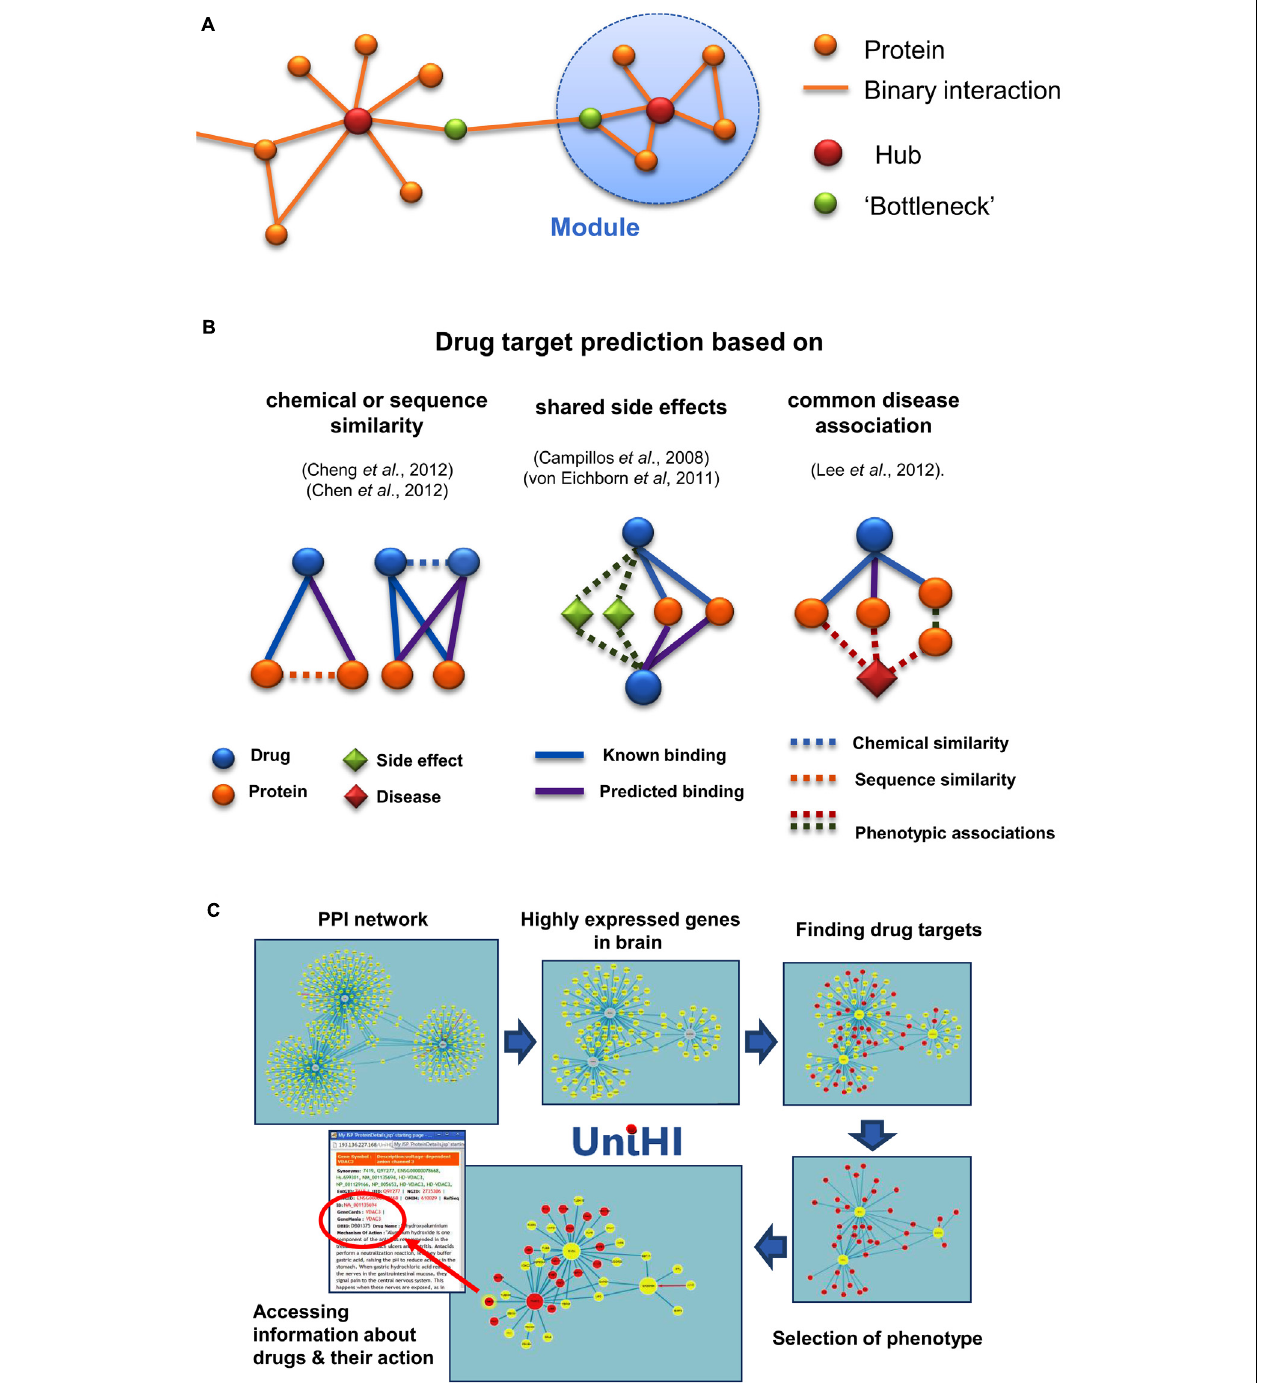
derives tissue and phenotype-specific networks, which can be scrutinized for known drug targets. In the example shown, an interaction network with GADD45A , SNCA , PARK2 as central proteins was retrieved and filtered using gene expression data from the brain. Additional filtering steps, using drug–target data and phenotypic information (“nervous system phenotype”) from knock-out mice, generated a compact network of drug targets with potential relevance for neurological disorders. Information regarding the drugs and their mode of action can be interactively accessed within the displayed